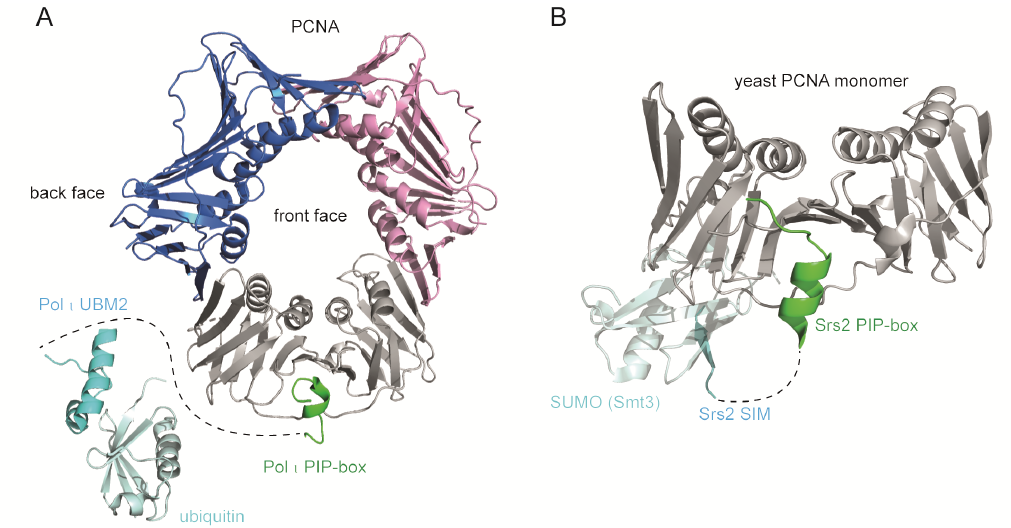
Figure 5. Multivalent binding modules of PCNA-interacting proteins. ( A ) TLS polymerases bind PCNA IDCL through a PIP-box motif and monoubiquitinated PCNA through ubiquitin-binding domains (UBD). Overlay of monoubiquitinated PCNA (3TBL) [46], Pol τ PIP-PCNA co-structure (2ZVM) [21], and Pol τ UBM2-ubiquitin co-structure (2KHW) [62]. Pol τ PIP-box binds the IDCL at the front face of PCNA, while Pol τ UBM2 binds ubiquitin positioned radially towards the back face of PCNA. A dashed line represents the region between Pol τ PIP-box (445–457aa) and UBM2 (701–732aa). The 59Å distance between the last residue of the PIP-box and the first residue of UBM2 allows a flexible conformation of the intervening region. ( B ) Yeast Srs2 binds PCNA IDCL through a PIP-box motif (1148–1161aa) and SUMOylated PCNA on the back face of the PCNA ring through a SUMO-interacting motif (SIM) (1168–1174aa) (3V62) [20]. However, the 36Å distance between the last residue of the PIP-box and the